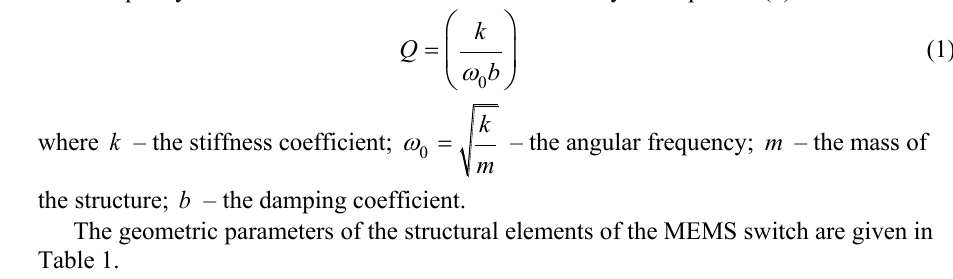
Table 1. Geometric parameters of MEMS switch design